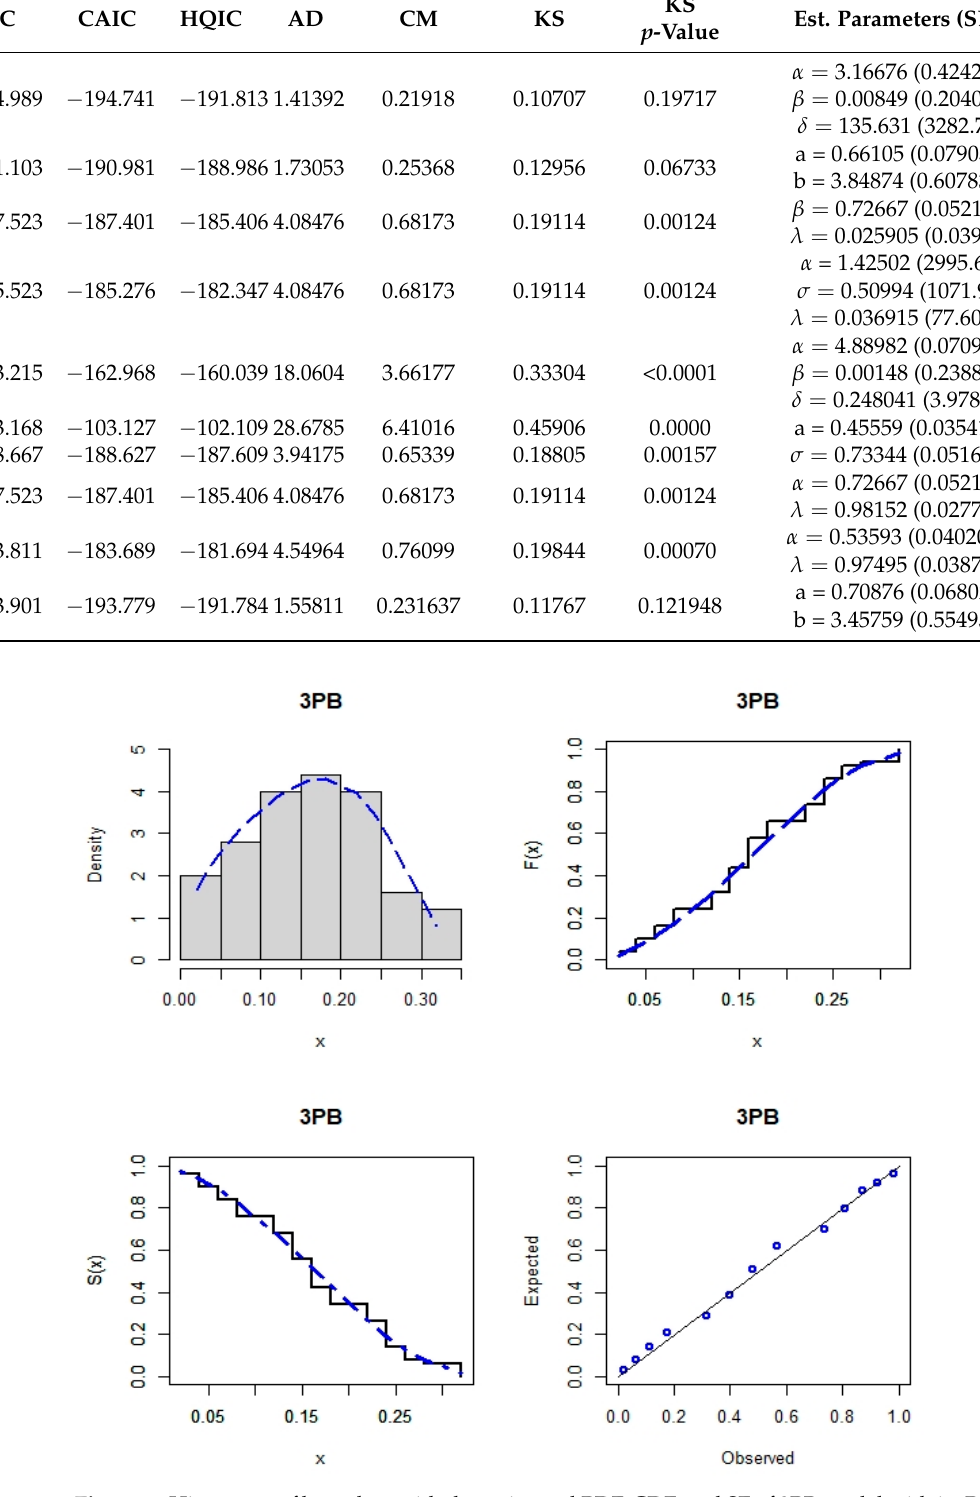
Figure 6. Histogram of burr data with the estimated PDF, CDF, and SF of 3PB model with its P-P plots.